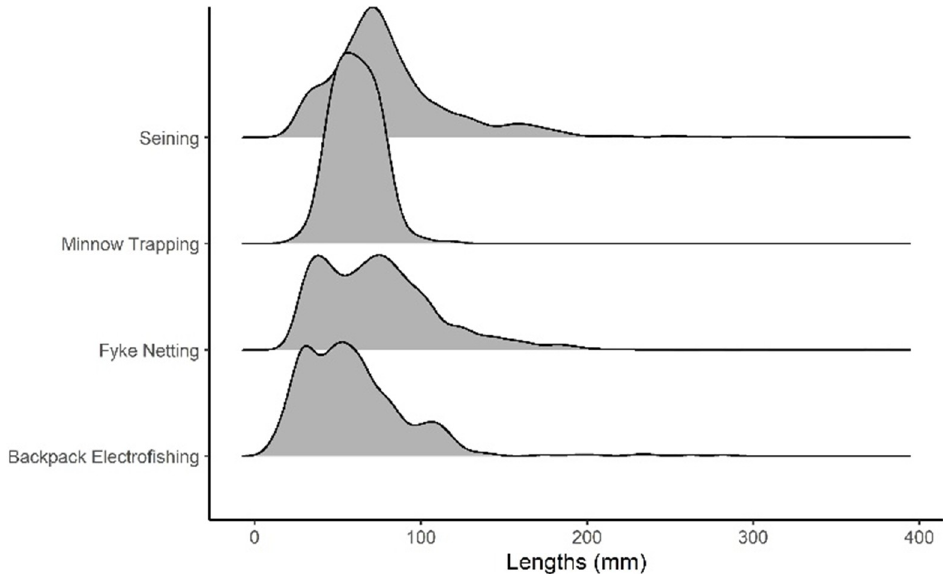
Fig 3. Length frequency distribution for lengths as sampled by each sampling method (n = 1716, 215, 1344, and 491) respectively for seining, minnow trapping, fyke netting, and backpack electrofishing. Height of the shaded region for each sampling method along y-axis represents the frequency of fishes of that